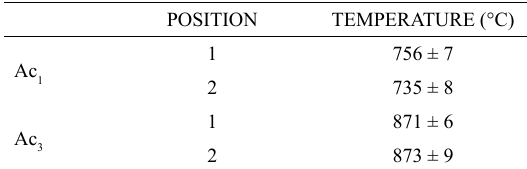
Position 1: outer region; Position 2: inner